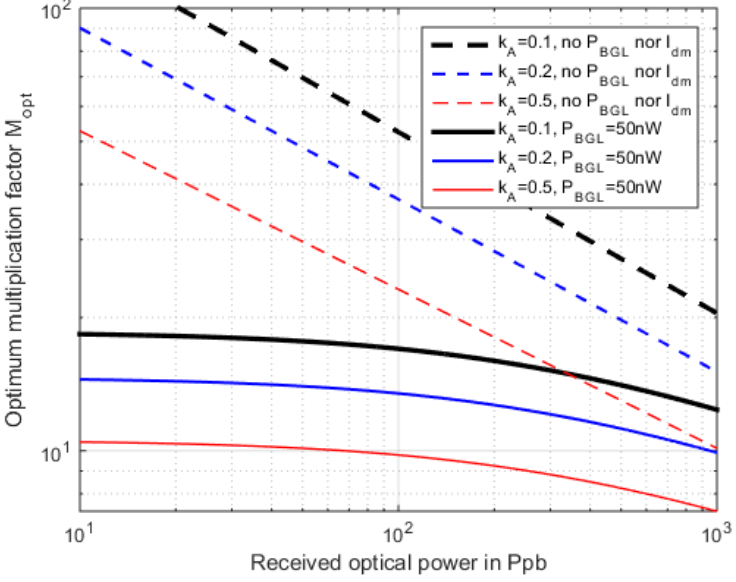
Figure 12. Optimum multiplication factor M opt with an NRZ-50:50 modulated signal for different ionization ratios, according to (24).